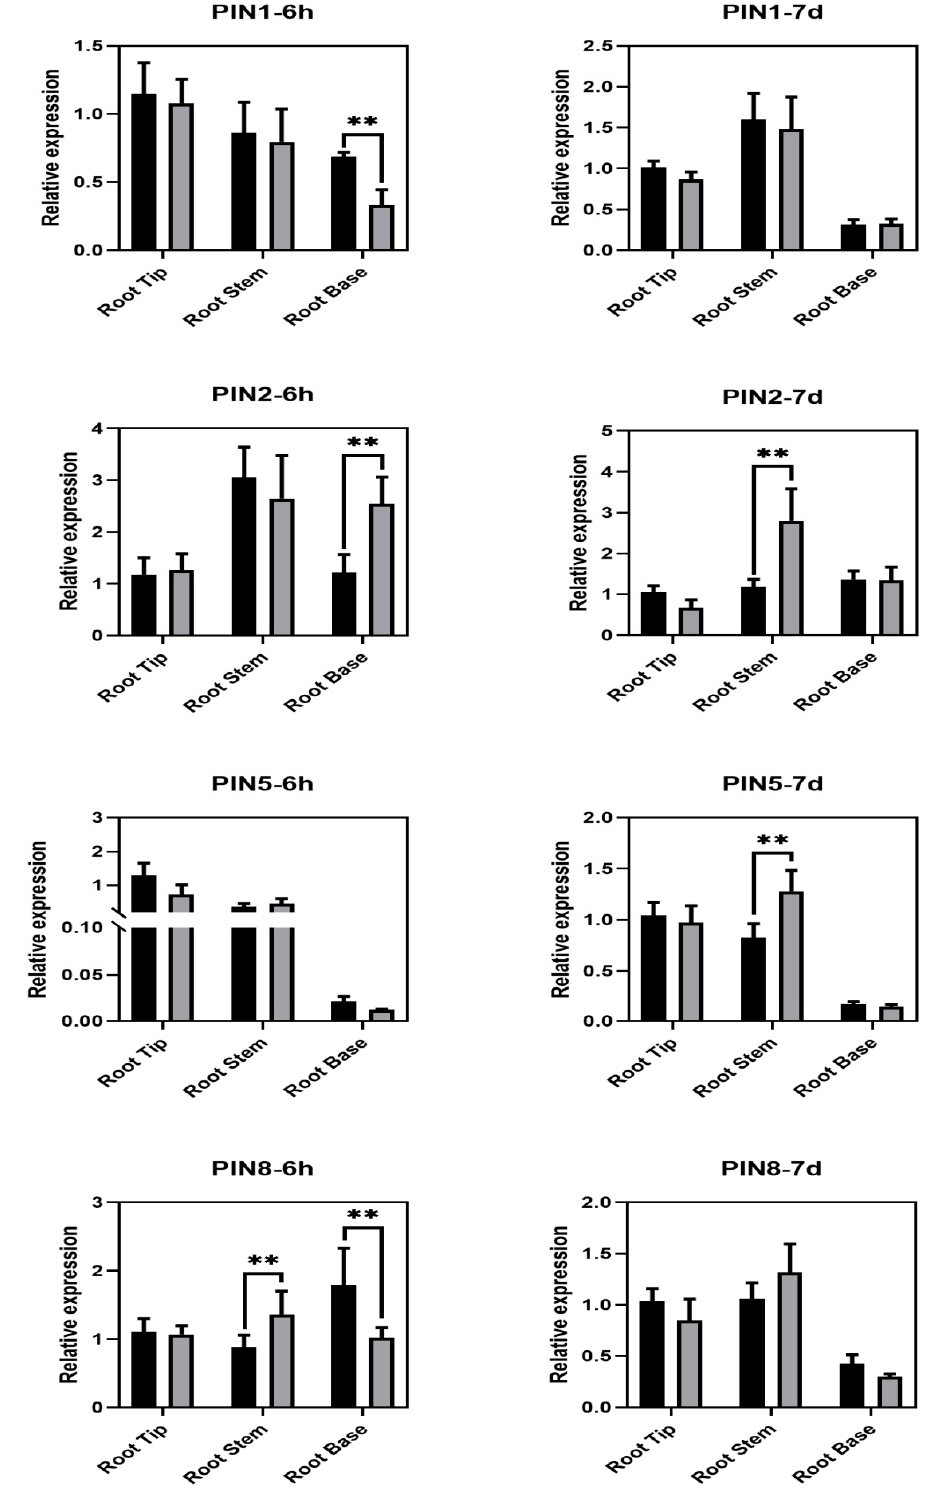
Figure 5. Change in the expression of PIN gene family members in tea roots with and without Al treatment after incubation for 6 h and 7 d (** indicates significance at 0.01 probability level).